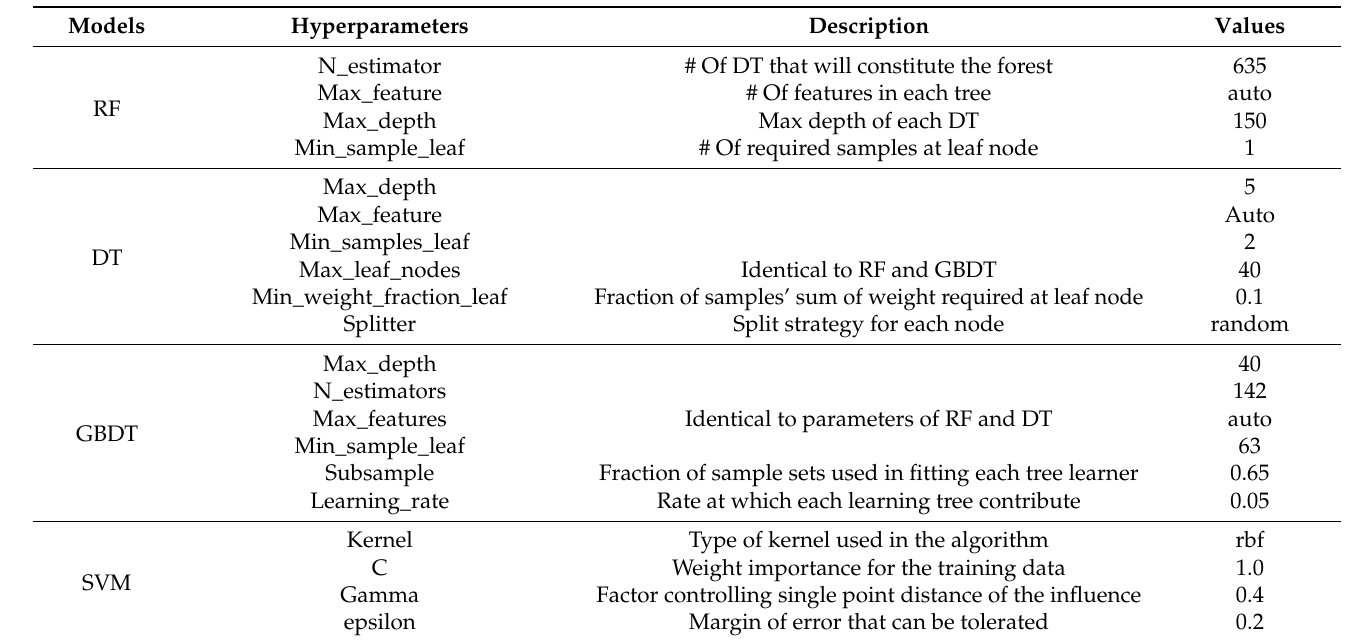
Table 2. Hyperparameter tuning of the different models used.